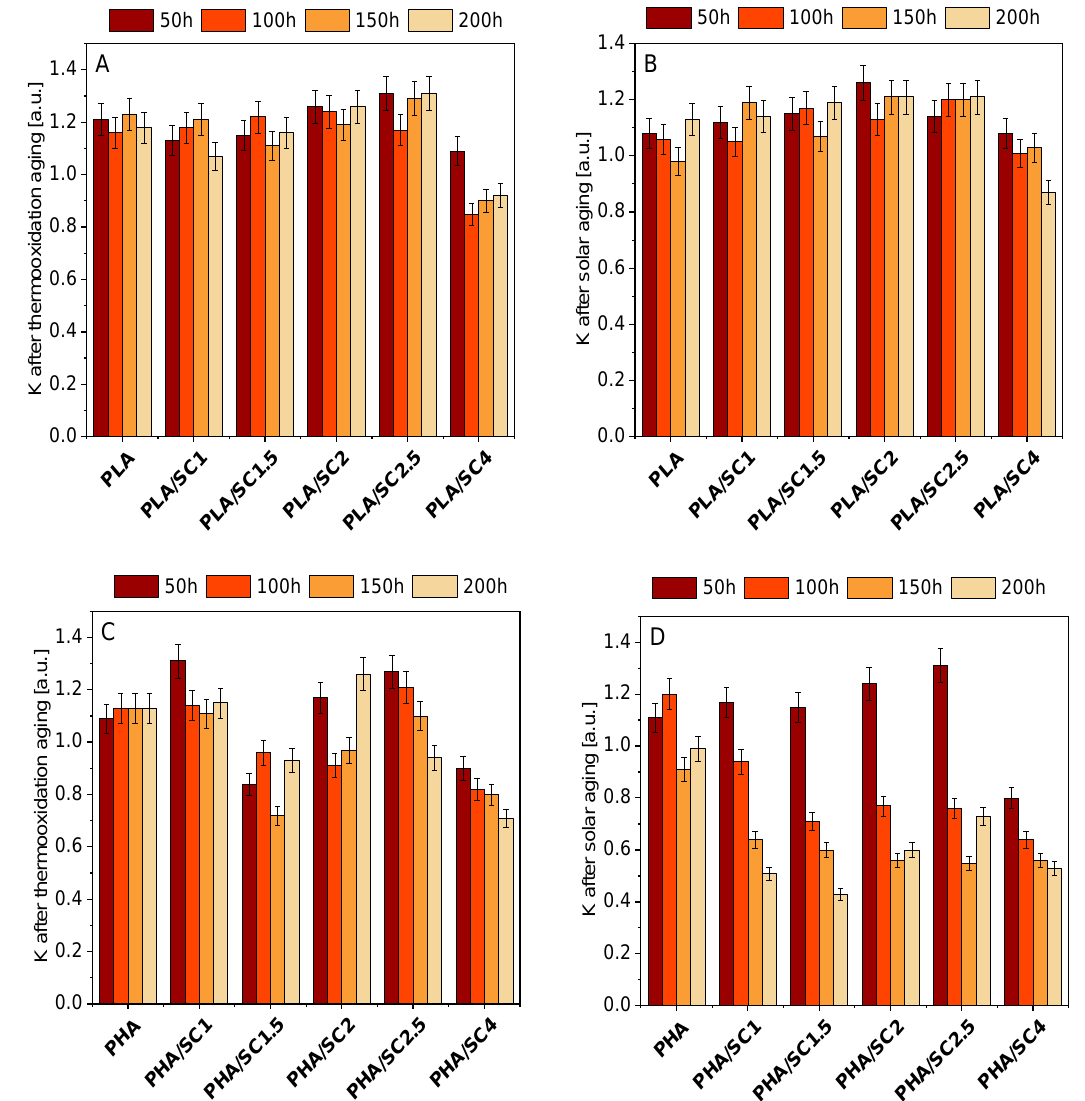
Figure 7. The aging coefficient (K) of PLA ( A , B ) and PHA ( C , D ) with succinic acid (SC) after thermooxidation and solar ageing. Resistance to degradation of samples: K = 1 resistant, K = 0 susceptible.